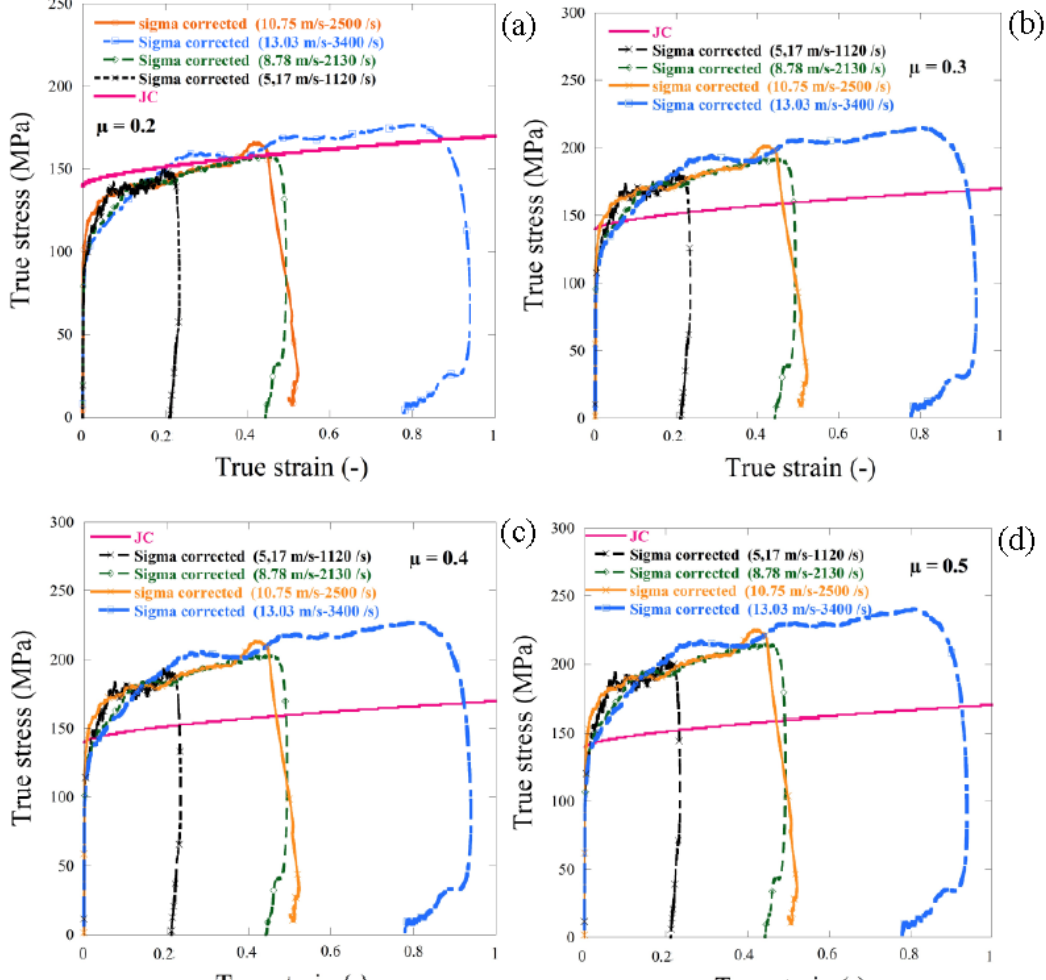
Figure 14. Experimental dynamic compression result (using the HSPB system) curves with different friction corrections. ( a ) μ = 0.2, ( b ) μ = 0.3, ( c ) μ = 0.4 and ( d ) μ = 0.5.